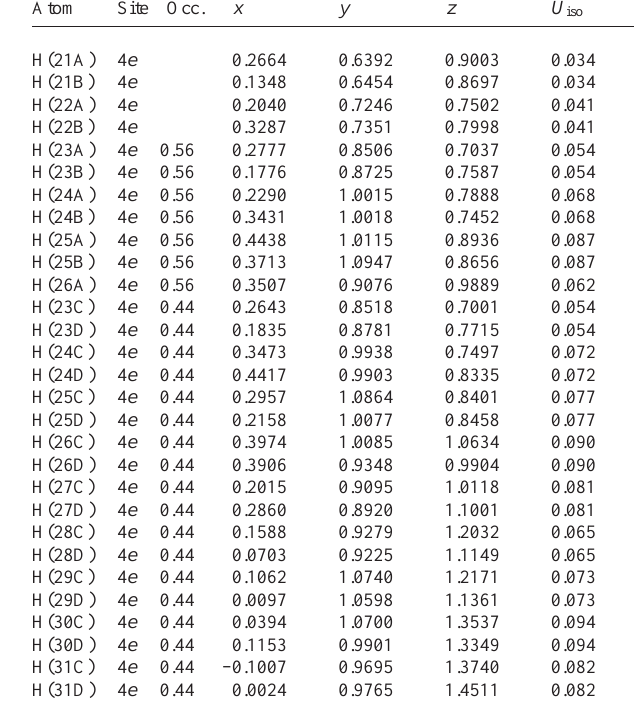
Table 2. Atomic coordinates and displacement parameters (in Å 2 ) . Atom Site